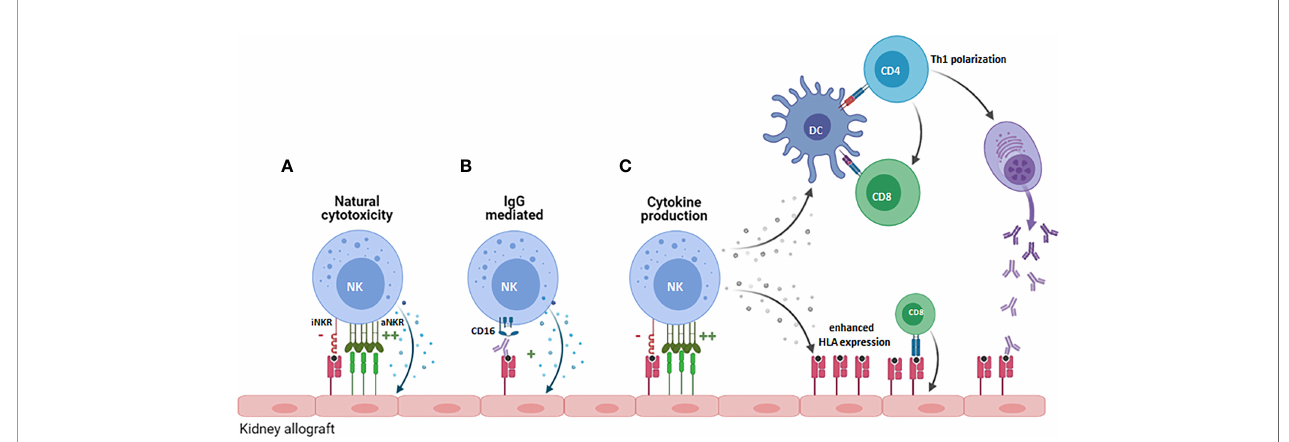
FIGURE 1 | Potential role for NK cells in promoting allograft rejection. NK cells can contribute to allograft rejection in several ways: (A) By mediating direct cytoxicity against cells of the allograft that increasingly express cellular-stress or virus-associated activating ligands. (B) Via antibody-dependent cellular cytoxicity upon binding of CD16 on the NK cell to anti-HLA antibodies. (C) By producing proin fl ammatory cytokines like IFN- ϒ , that promote Th1 polarization of CD4 + cells, priming and activation of CD8 + T cells directed against the allograft and by stimulating B cell production of pathogenic IgG antibodies. iNKR, inhibitory NK cell receptor; aNKR, activating NK cell